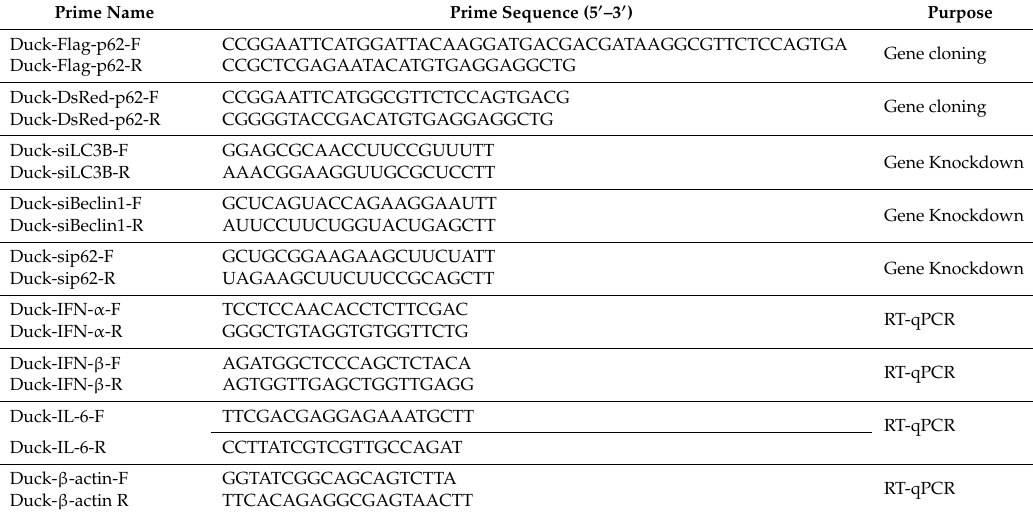
Table 1. Primer sequences used in this